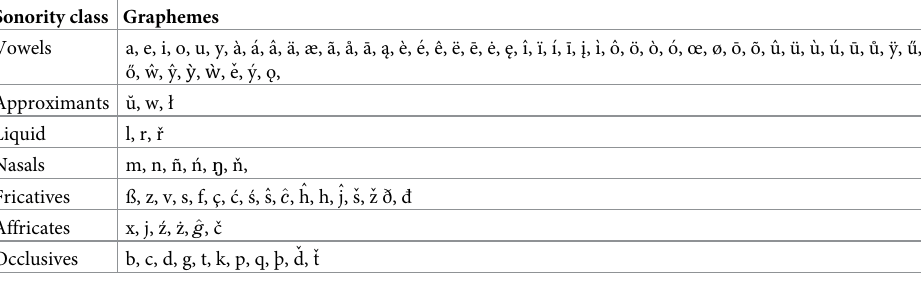
Table 1. The adopted grapheme classification into seven sonority classes. Sonority class Graphemes